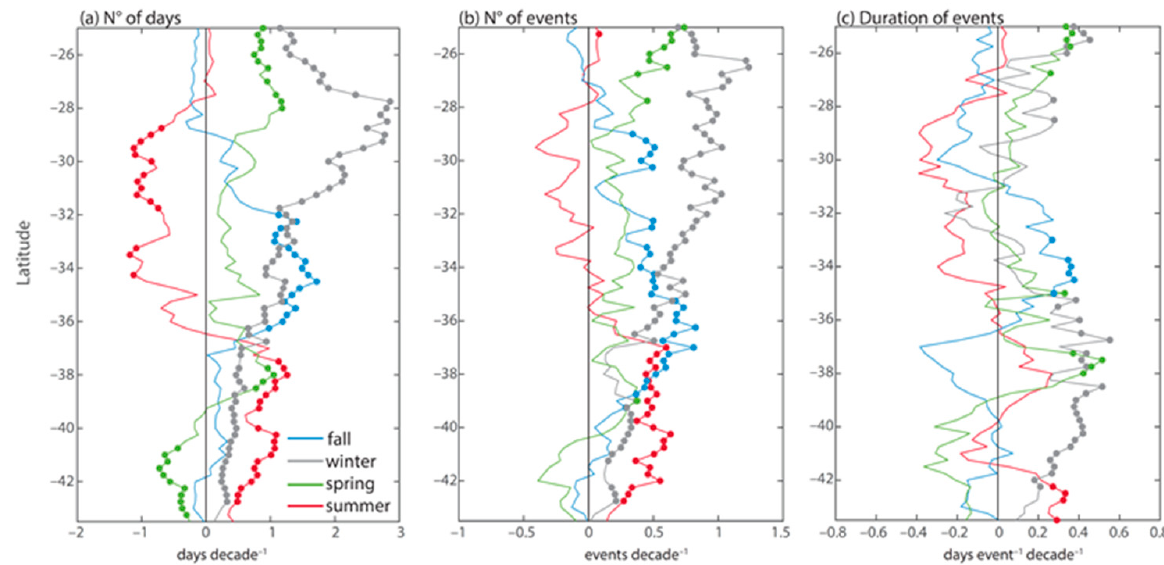
Figure 7. ( a ) Trends in the number of windy days, ( b ) trends in the number of CLLJ events and ( c ) trends in the duration of the CLLJ events. Dots represent locations where trends are significant. The time evolution of the number of WDs and CLLJ events are shown at selected locations as time series of seasonal means (austral summer and winter) offshore north- central Chile at 30 ◦ S and south-central Chile at 38 ◦ S (Figure 8). Off 30 ◦ S positive trends were observed during winter, while negative trends were found in summer. In contrast, positive trends were found at 38 ◦ S, more markedly during summer than winter. Trends that were significant at p = 0.1 are highlighted in Figure 8. The time series show